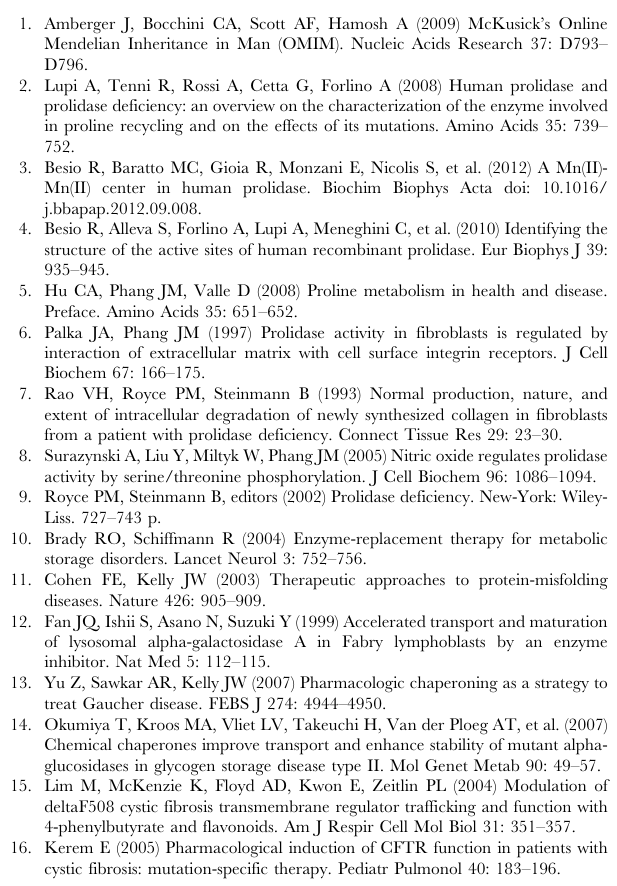
Figure S1 Protein melting temperatures in the absence of the cofactor as revealed by Thermofluor Technology. The solvatochromic dye SYPRO orange was used as an indicator of protein unfolding (fluorescence excitation l = 492 nm; fluores- cence emission l = 568 nm). Figure S2 Alignment of different prolidase amino acid sequences from the region involved in cofactor binding. Metal binding residues are indicated by arrows. GenBank H Identifier (gi) numbers of the displayed sequences are as follow: 189842 ( H. sapiens ), 296477856 ( B. Taurus ), 9795244 ( M. musculus ),